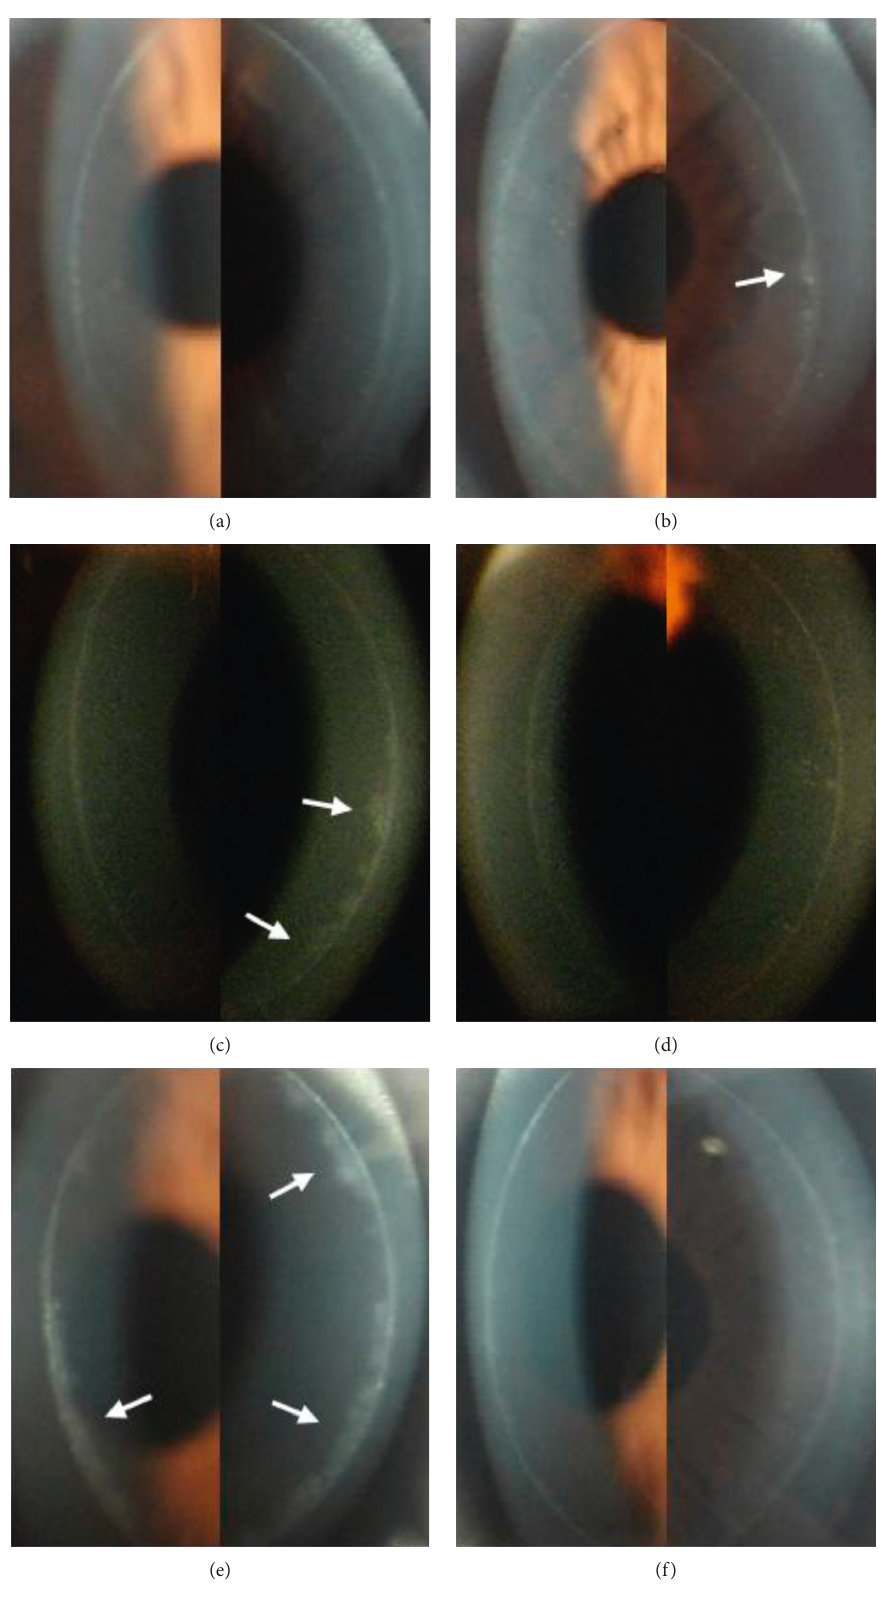
Figure 4: Corneal flap margin and adjacent regions photographed by slit-lamp biomicroscopy at 6 months after surgery. A narrower and less spiculated circumferential band in the BCL-treated right eye (a) and a circumferential band with a spiculated temporal side (white arrow) in the non-BCL-treated left eye (b) of a patient. A circumferential band that is wider and more spiculated on the nasal side (white arrow) in the non-BCL-treated right eye (c) and a narrower and less spiculated circumferential band in the BCL-treated left eye (d) of a patient. A circumferential band that is wide and spiculated on both the temporal and nasal sides (white arrow) in the non-BCL-treated right eye (e) and a smooth, narrow circumferential band in the BCL-treated left eye (f) of a